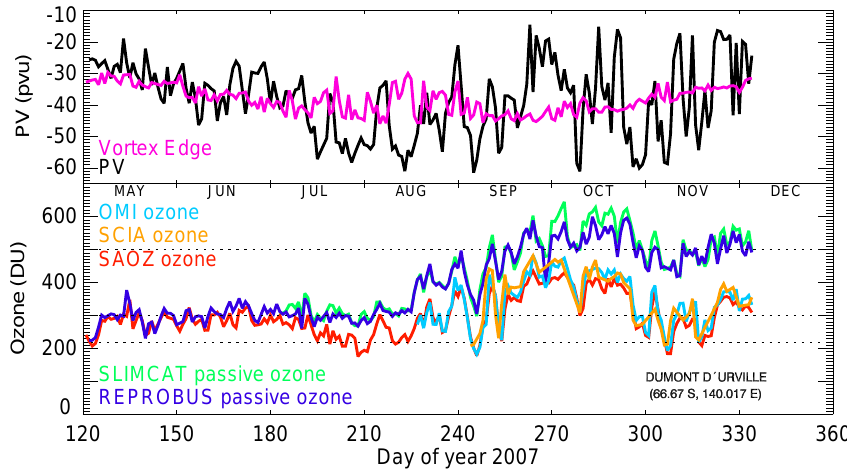
Fig. 3. Temporal evolution of various parametrs used for the computation of ozone loss at Dumont d’Urville in 2007. Top: ECMWF potential vorticity at 475K (black), and polar vortex edge (magenta). Bottom: SAOZ (red), OMI (cyan) and SCIA (yellow) daily mean total ozone and SLIMCAT (green) and REPROBUS (blue) passive ozone (tracer). The horizontal bars represent the 220DU ozone hole criterion, the 300DU average pre-ozone hole value, and the 500DU average spring column in the absence of